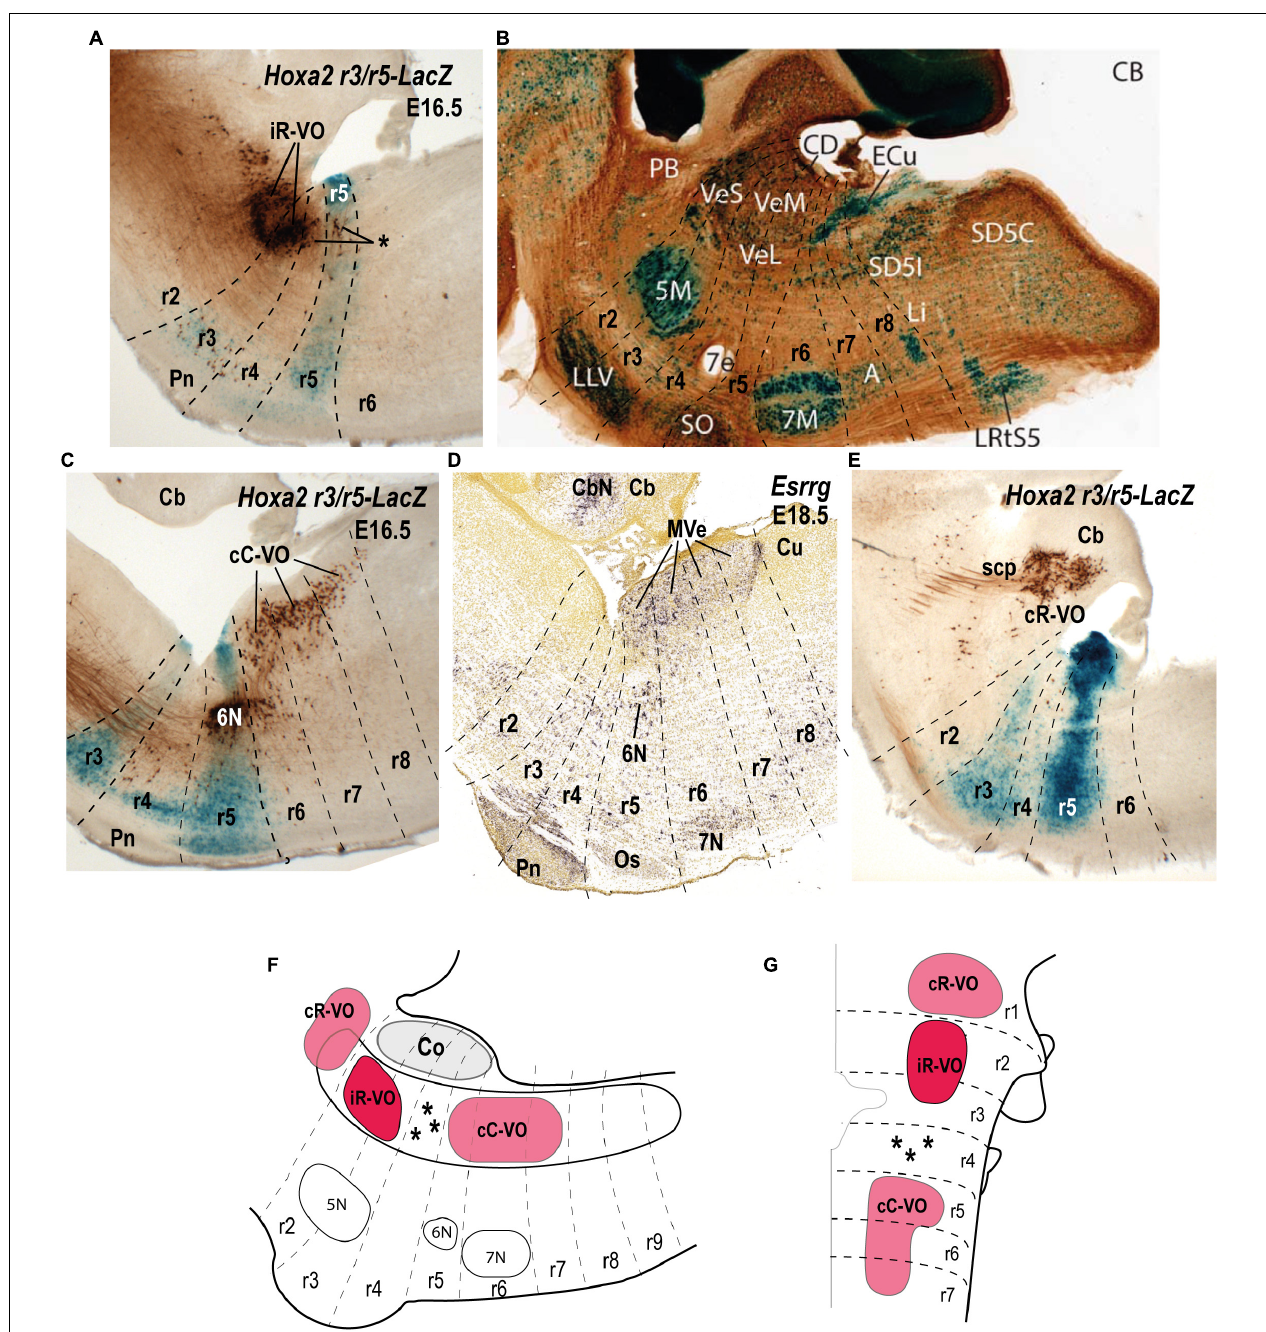
FIGURE 5 | Relationship of the vestibulo-ocular neuron groups to the rhombomeres in sagittal sections of E16.5/E18.5 mouse embryos. (A) Biotin-conjugated dextran amine (BDA) labeling of the ipsilateral rostral vestibulo-ocular group (iR-VO) relative to the r3 and r5 domains in a r3/r5:lacZ transgenic mouse at E16.5 (see Pasqualetti et al., 2007). Asterisk indicates scattered labeled cells in r4 and r5. (B) Sagittal section of an adult AZIN1-lacZ mouse counterstained with antibodies to calbindin (CB). Neurons of the superior, lateral and medial nuclei are moderately AZIN2 positive [modified from Martinez-de-la-Torre et al. (2018); their Figure 1B ]. (C) The contralateral caudal vestibulo-ocular neuron group (cC-VO) labeled by BDA in a sagittal section of a r3/r5:lacZ transgenic mouse at E16.5 (see Pasqualetti et al., 2007). This section is medial to the section shown in panel (A) . (D) Esrrg expression in the medial vestibular nucleus (MVe) in a sagittal section at E18.5 (experiment 100071978; image 16 of 16: Allen Developing Mouse Brain Atlas). (E) The contralateral rostral vestibulo-ocular group (cR-VO) labeled by BDA in a section of the r3/r5:lacZ transgenic mouse at E16.5 [from Pasqualetti et al. (2007)]. (F,G) Schematic comparison of the vestibulo-ocular neuron groups according to the fate map reported by Pasqualetti et al. (2007). 5N/5M, motor trigeminal nucleus; 6N, abducens nucleus; 7e, efferent facial fibers; 7N/7M, facial nucleus; Cb, cerebellum; CbN, cerebellar nuclei; CD, dorsal cochlear nucleus; ECu, external cuneate nucleus; LVe/VeL, lateral vestibular nucleus MVe/VeM, medial vestibular nucleus; Os/SO, superior olive; Pn, pontine nuclei; r, rhombomere; scp, superior cerebellar peduncle; Sol, solitary nucleus; SVe/VeS, superior vestibular nucleus.